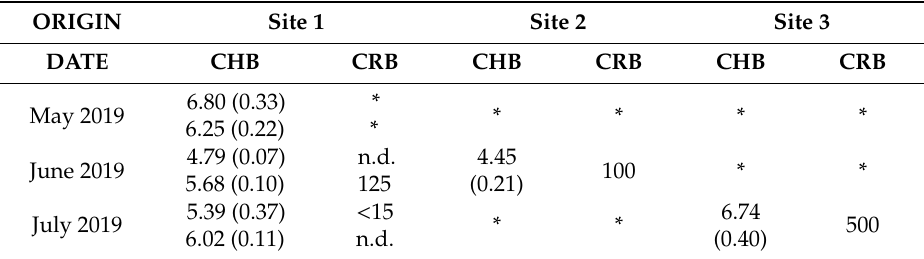
Table 5. Culturable heterotrophic bacteria (CHB; log CFU / g) and ciprofloxacin-resistant bacteria (CRB; CFU / g) present in mussels from different production zones of Galicia.